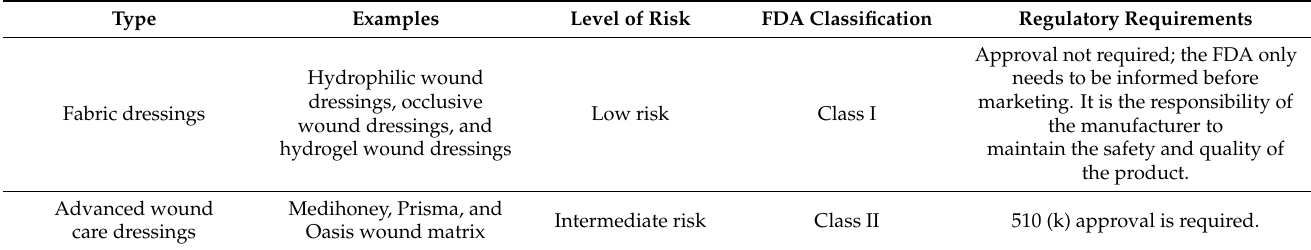
Table 1. List of dressings and associated level of risk [17]. Adapted from open-access